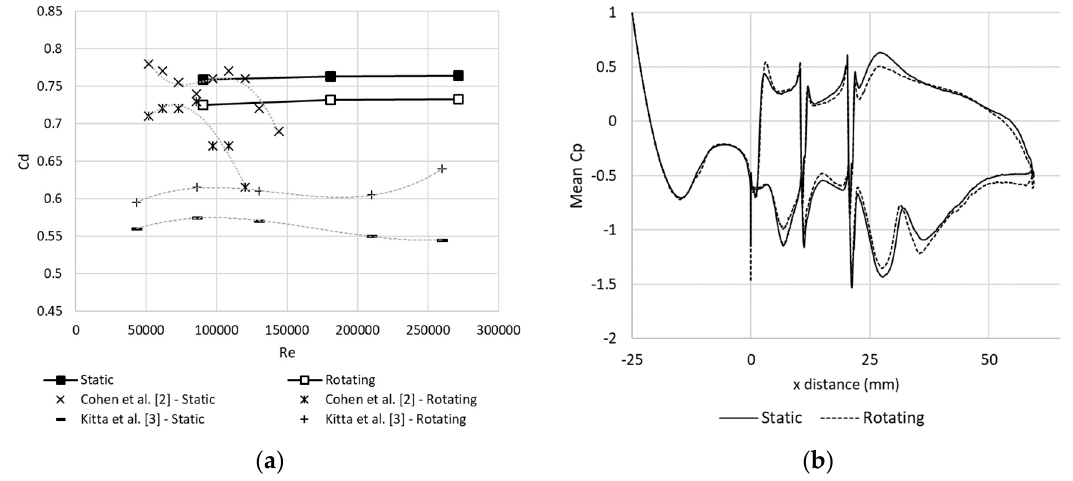
Figure 2. ( a ) Measured drag coefficient vs Reynolds number; ( b ) Mean pressure coefficient C p acting along shuttlecock, Re = 2.7 × 10 5 .